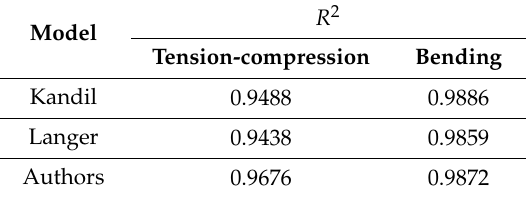
(tension-compression and bending, Table 2). Table 2. The correlation parameter R 2 for individual models of tension-compression and